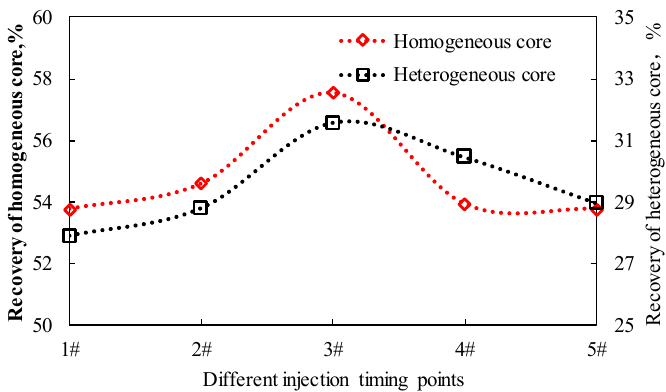
Figure 5. Polymer injection timing effect on oil recovery effect.